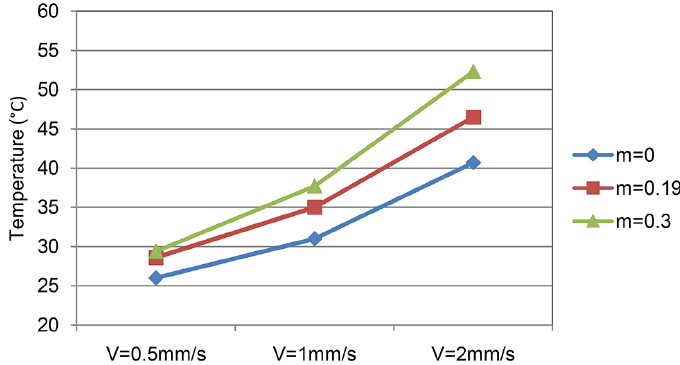
Fig.4: Maximum die temperature as a function of velocity and friction (immediately after end of the process)